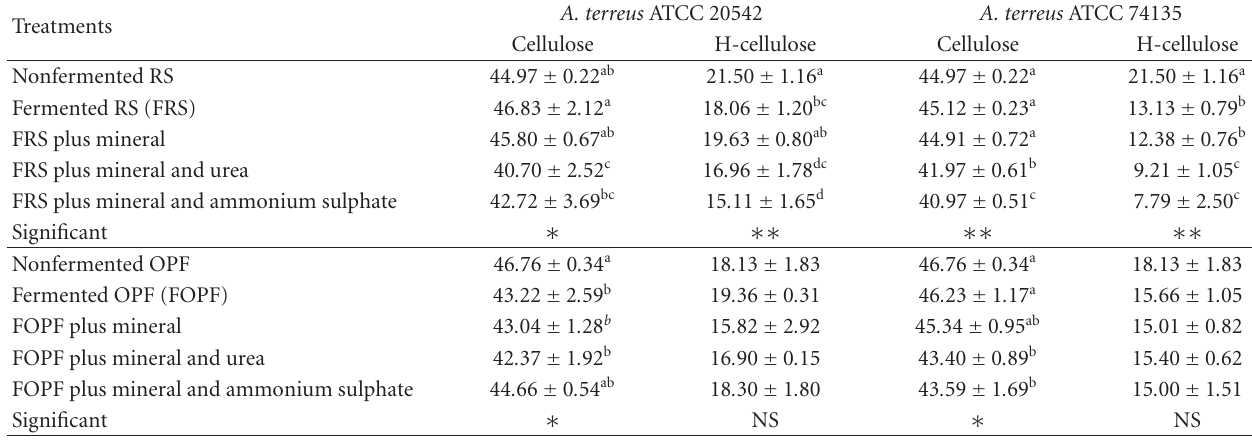
Table 2: E ff ect of SSF on cellulose and hemicellulose contents of RS and OPF (% of dry mater).